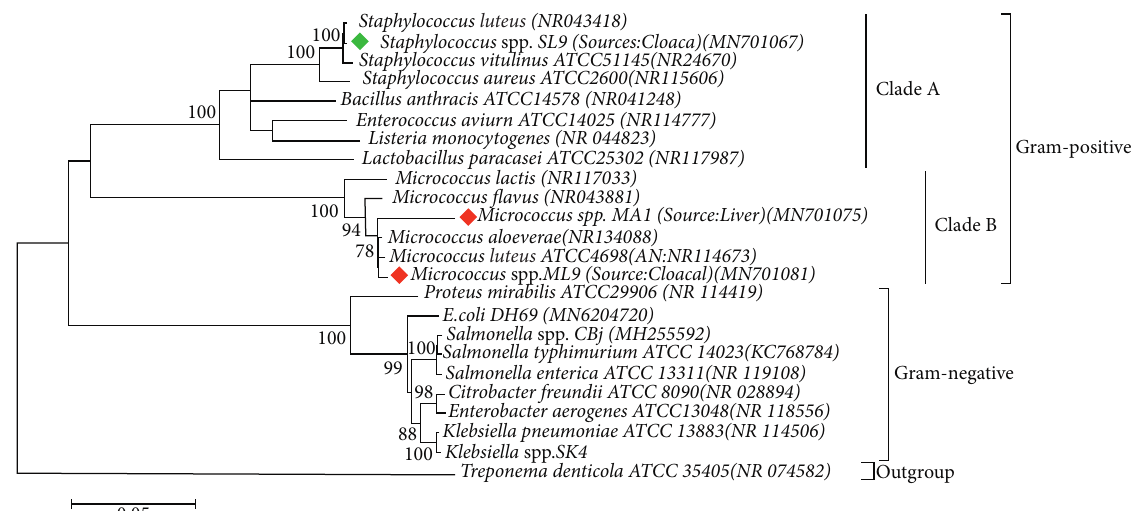
Figure 1: Phylogenetic tree predicted by the neighbor-joining method using 16S rRNA gene sequences. The evolutionary distances were computed using the Kimura 2-parameter model method and are in the units of the number of base substitutions per site. The bootstrap considered 1000 replicates. The scale bar represents the expected number of substitutions averaged over all the analyzed sites. The optimal tree with the sum of branch length � 0.98517644 is shown here. The results obtained with sequencing exhibited two different clusters, and we referred to them as clusters A and B. However, due to the high-sequence similarity, the nodes are not very stable and sequencing errors in some of the older sequences may well affect the topology of the tree. Cluster A contains Staphylococcus lentus . Cluster B contains both Micrococcus luteus and Micrococcus aloeverae strains. Treponema denticola was used as outgroup.